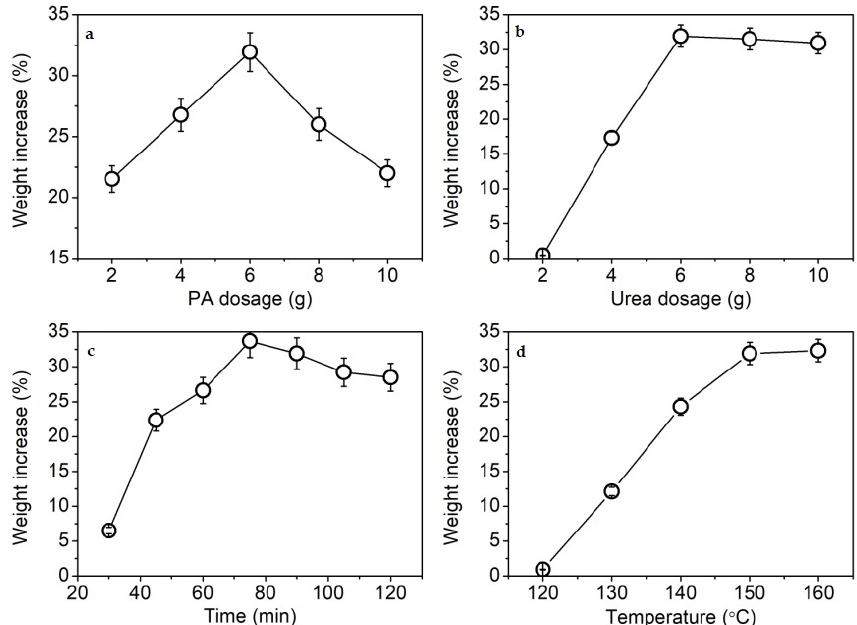
Figure 1. Weight increase percentage of KF at various PA dosages ( a ), urea dosages ( b ), reaction times ( c ), and reaction temperatures ( d ).